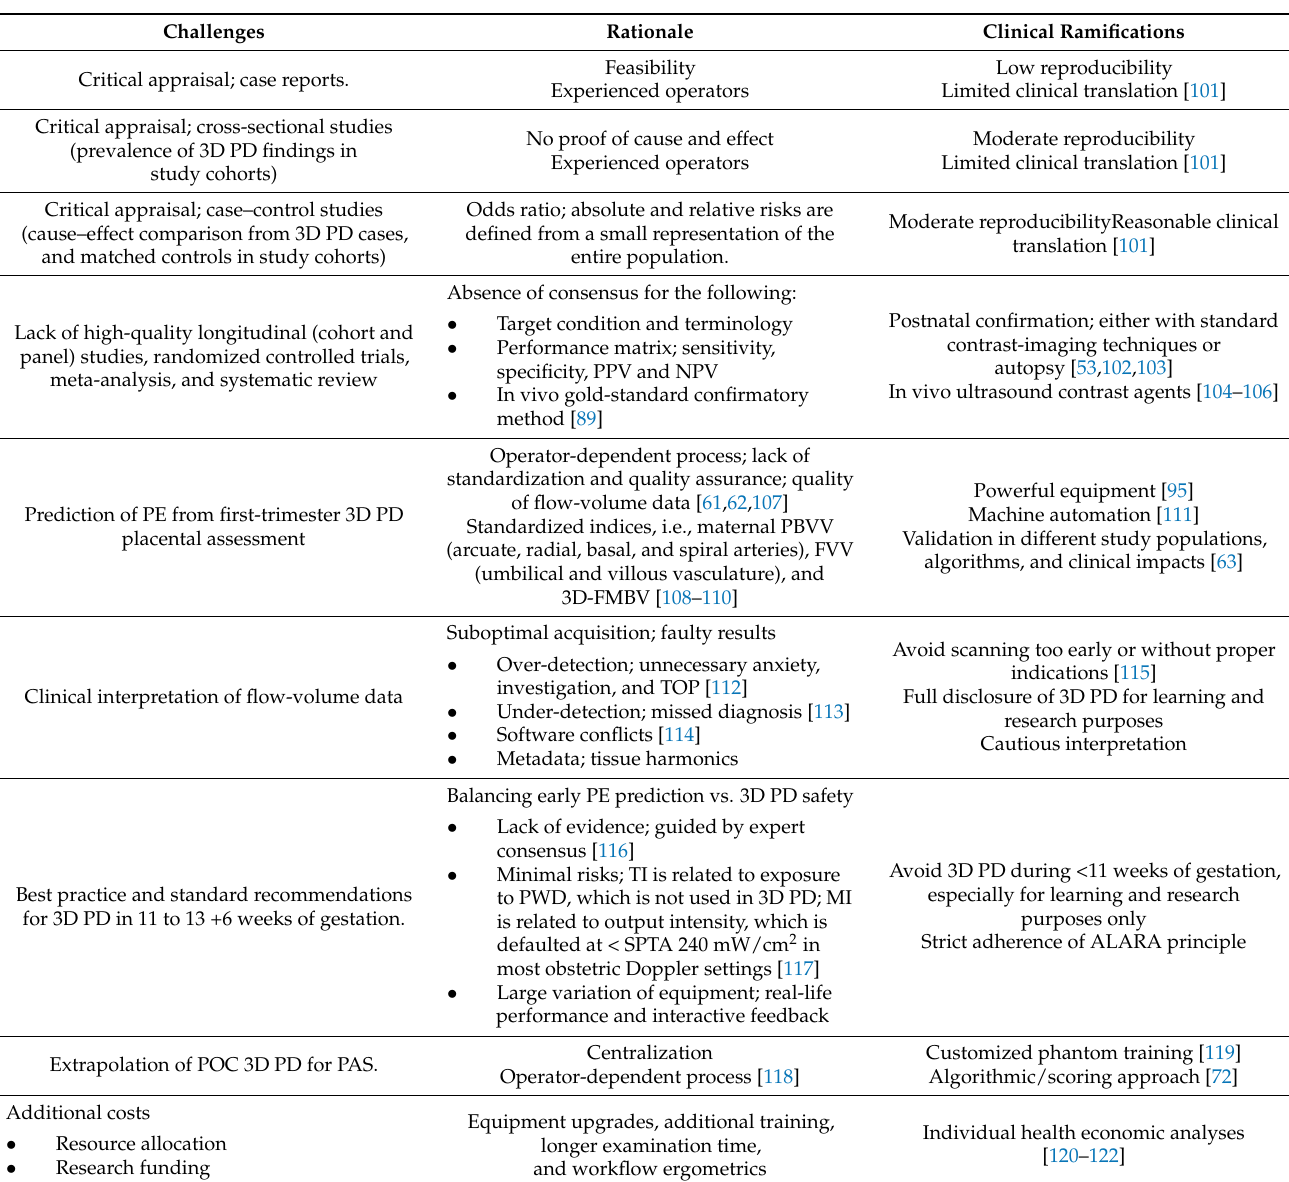
Table 1. Current challenges of three-dimensional sonoangiography for prenatal assessment. Abbreviations: 3D-FMBV, 3D-fractional moving blood volume; 3D PD, three-dimensional power Doppler; ALARA, as low as reasonably achievable; FVV, fetal vascular volume; MI, Mechanical Index; PAS, placenta accreta spectrum; PBVV, placental bed vascular volume; PE, preeclampsia; POC, point-of-care; PPV, positive predictive value; NPV, negative predictive value; SPTA, spatial peak temporal average; TI, Thermal Index; TOP, termination of